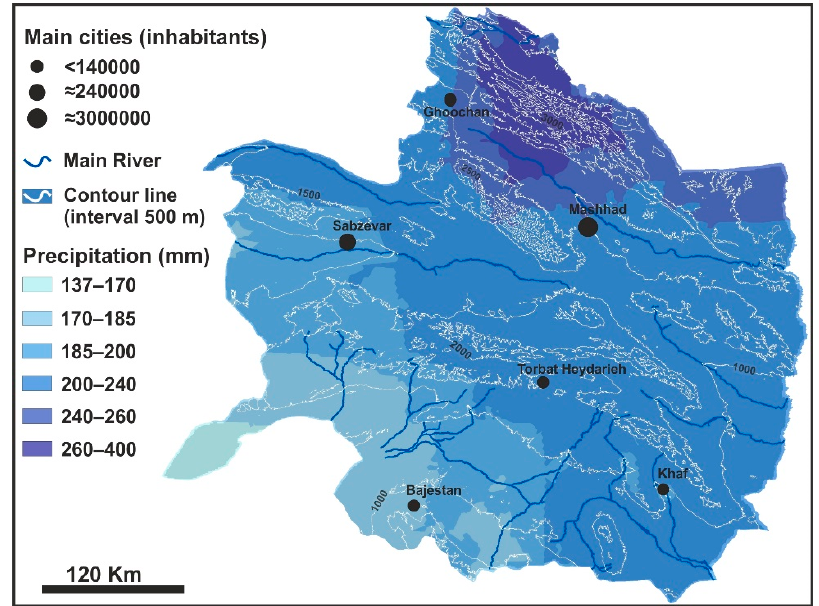
Figure 9. Annual precipitation Map of Khorasan Razavi province interpolated by Ordinary Co- Kriging, main streams and main settlements combined with the main contour lines of a DEM (Map sources: Digital Elevation Model GTOPO30: https://earthexplorer.usgs.gov (accessed on 28 April 2021)).